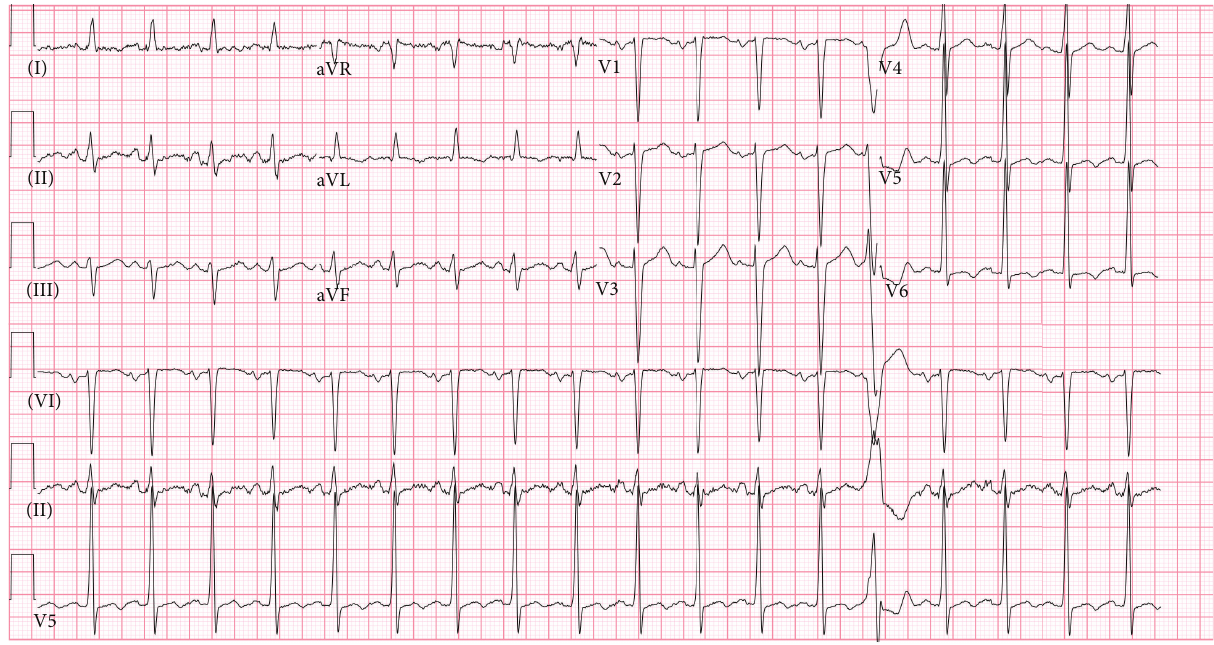
Figure 1: ECG on admission showing sinus tachycardia with a premature ventricular